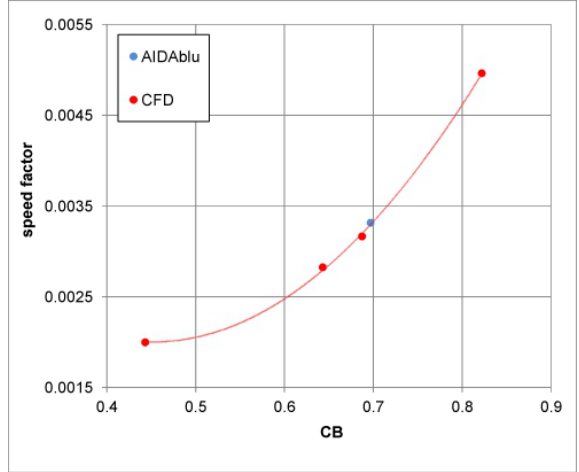
Figure 20. Squat functions for the cruise vessel derived from this experiment and for ships with different block coefficients CB calculated by means of CFD.